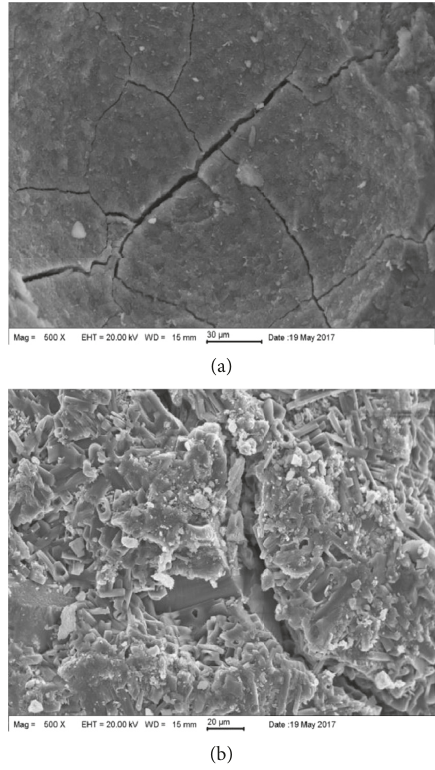
Figure 5: Scanning electron microscopy (SEM): (a) Geopolymer 9 increase 500x; (b) Geopolymer 4 increase